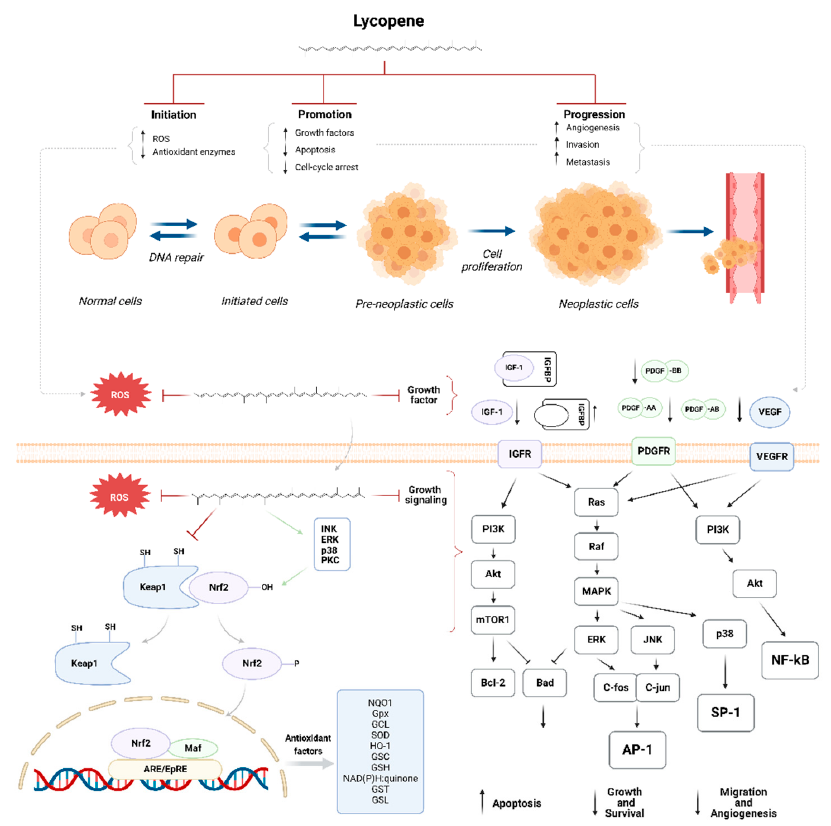
Figure 5. ( Top ) Phases of lycopene intervention in the carcinogenic process. ( Bottom left ) A possible mechanism of Nrf2 regulation by lycopene. ( Bottom right ) Lycopene induces cell-cycle arrest and apoptosis (Created with “https://www.biorender.com (accessed on 12 December